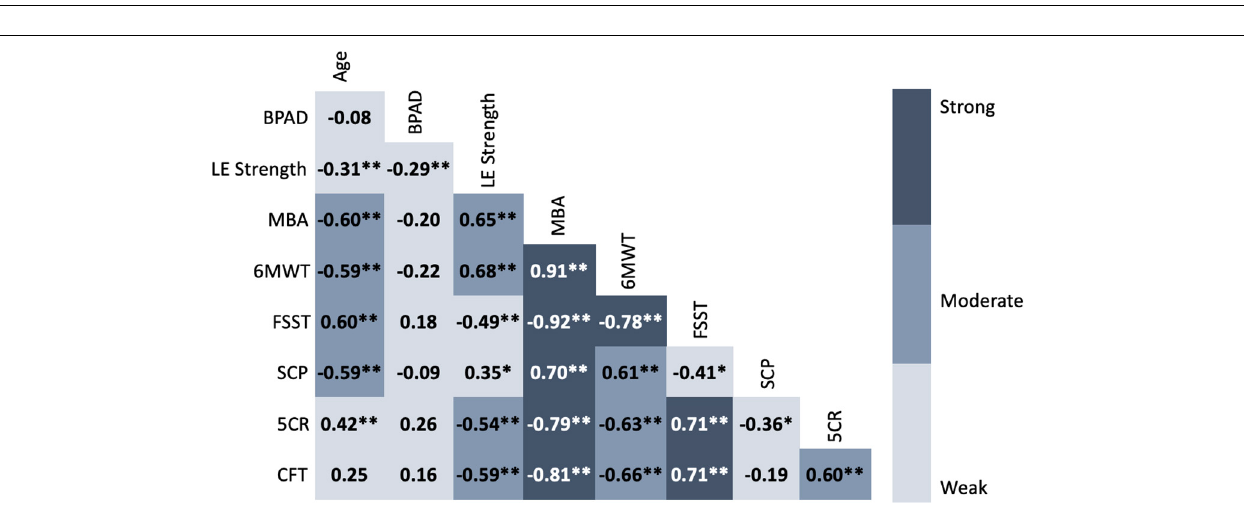
FIGURE 2 | Heterogeneity of brain-predicted age. Brain-predicted age from brainageR regression model. Scatterplot depicting chronological age (x-axis) by brain-predicted age (y-axis). Dashed line is the line of identity and solid black line is the regression line of chronological age on brain-predicted age.